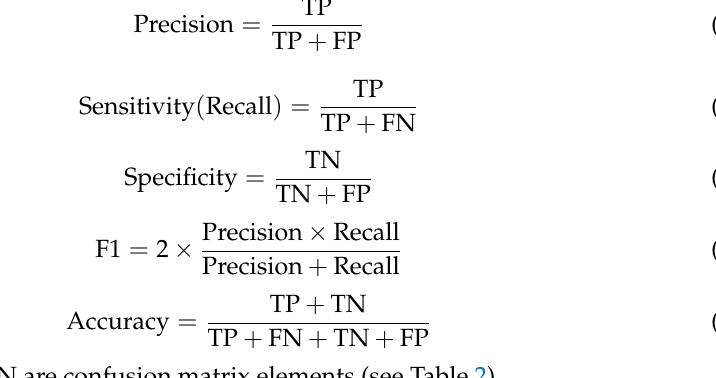
Table 2. Correlation calculations of confusion matrix (Cited from literature [30]). Based on the Gold Standard Disease